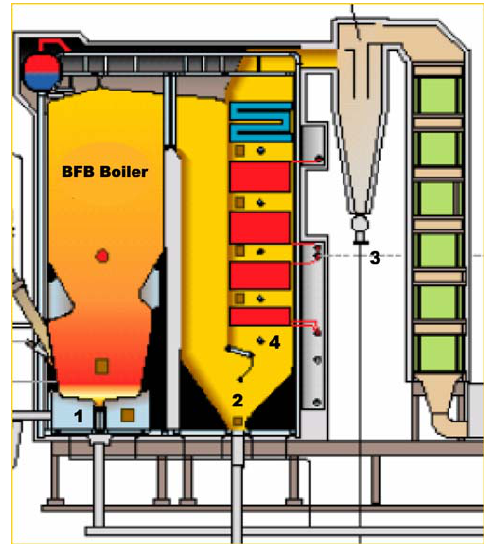
Figure 2. Ash sampling and measurement positions: (1) Bed ash; (2) Boiler ash; (3) Cyclone ash; and (4) Deposit probes upstream of the